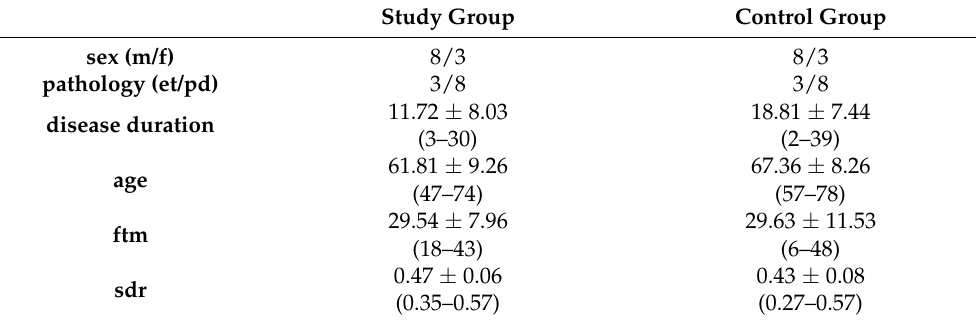
Table 1. Summary characteristics of study and control group for the comparison of procedural